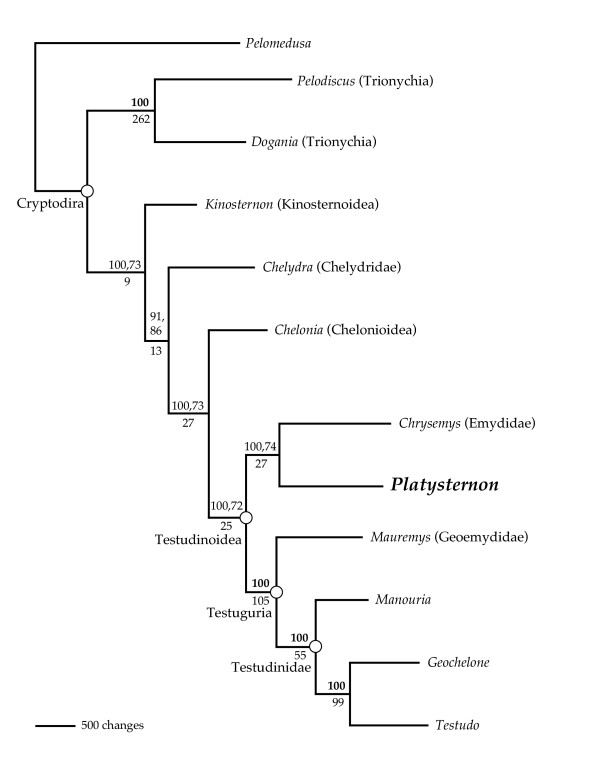
Phylogenetic relationships of turtles based on large mt alignments. Parsimony phylogram of the single tree recovered by all analyses (MP, BI, ML). Numbers above branches refer to BI posterior probabilities and MP bootstraps respectively, while a single bold number above a node indicates the identical BI and MP support for that node. Numbers below the nodes refer to decay indices.